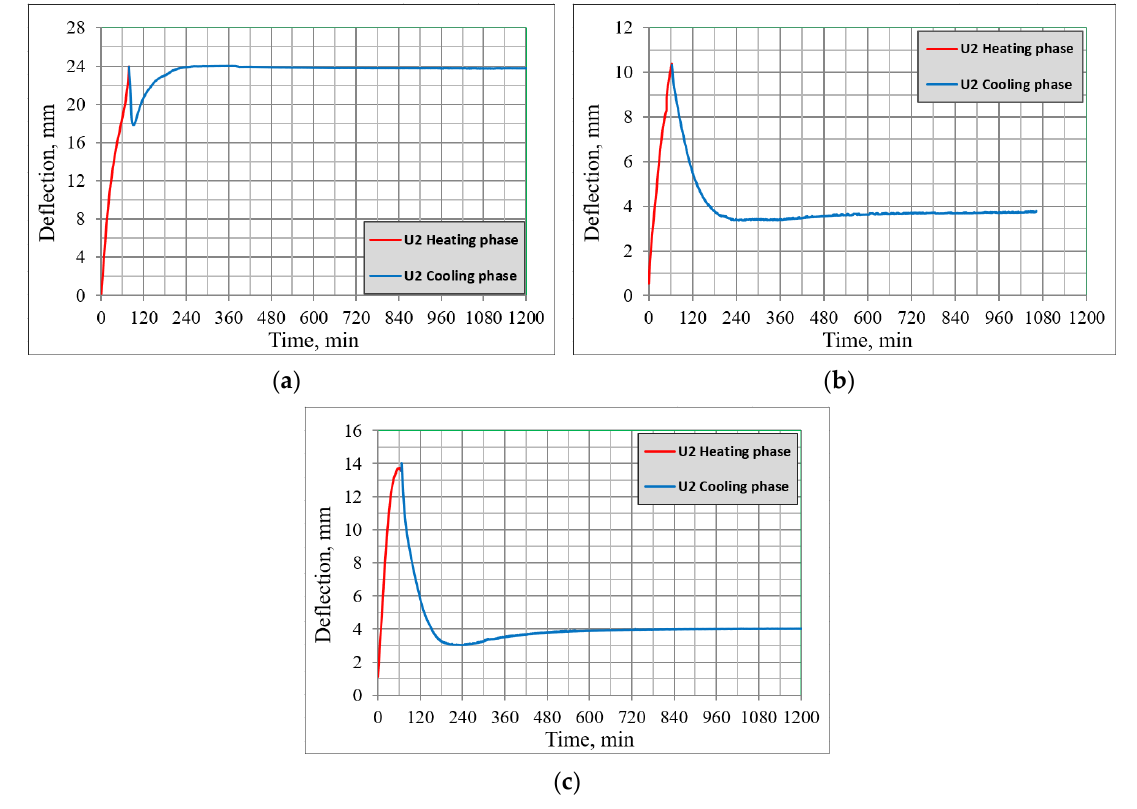
Figure 9. Mid-span deflections during the heating and cooling phases; ( a ) B2Ø14, ( b ) H2Ø14, ( c ) N2Ø14.